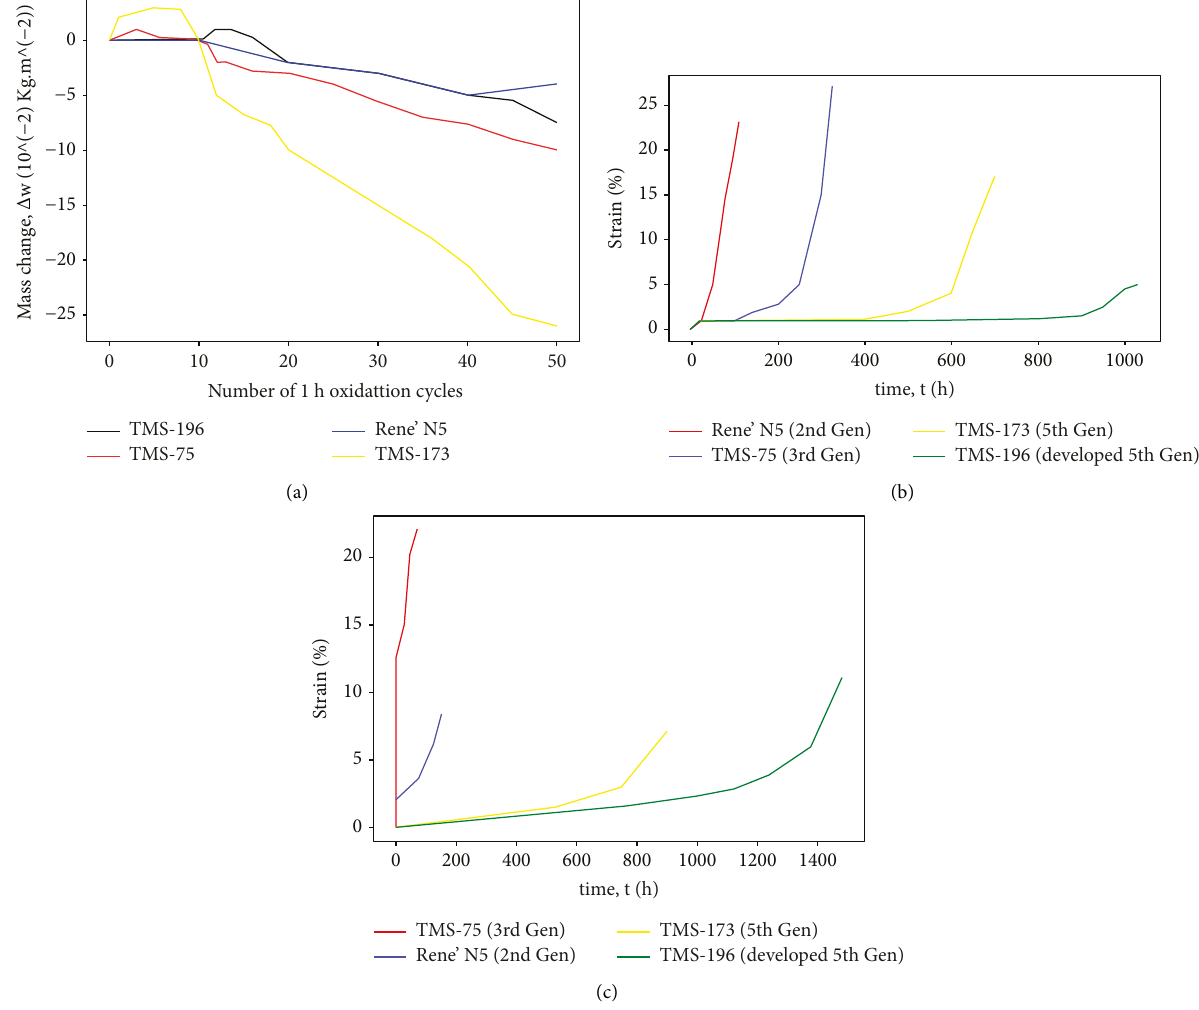
Figure 3: Graphical representation of (a) cyclic oxidation behaviour in terms of mass change. (b) and (c) Creep behaviour